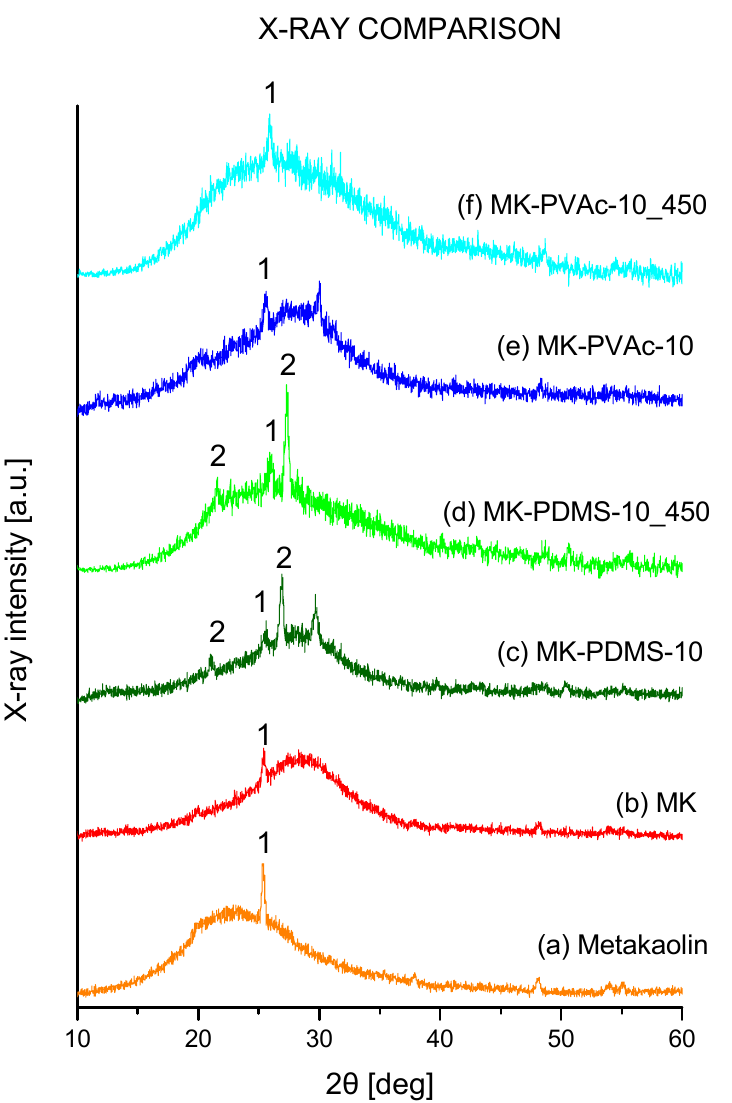
Figure 2. X-ray diffraction patterns of the samples: metakaolin ( a ), geopolymer (MK, ( b )), organic– inorganic geopolymer sample containing 10%wt of polydimethylsiloxane as obtained (MK- PDMS-10, ( c )) and after a 2 h thermal treatment in air at 450 for 2 h (MK-PDMS-10-_450, ( d )); geopolymer composite containing 10%wt of PVAc as prepared (MK-PVAc-10, ( e )) and after the sample has been treated at 450 ◦ C for 2 h (MK-PVAc-10_450, ( f )). The crystalline diffraction peaks at 2 θ = 21.1 ◦ , 25.4 ◦ and 26.9 ◦ are attributable to anatase (TiO 2 , peaks marked with “1”) and quartz (SiO 2 , peaks marked with “2”) crystalline phases.